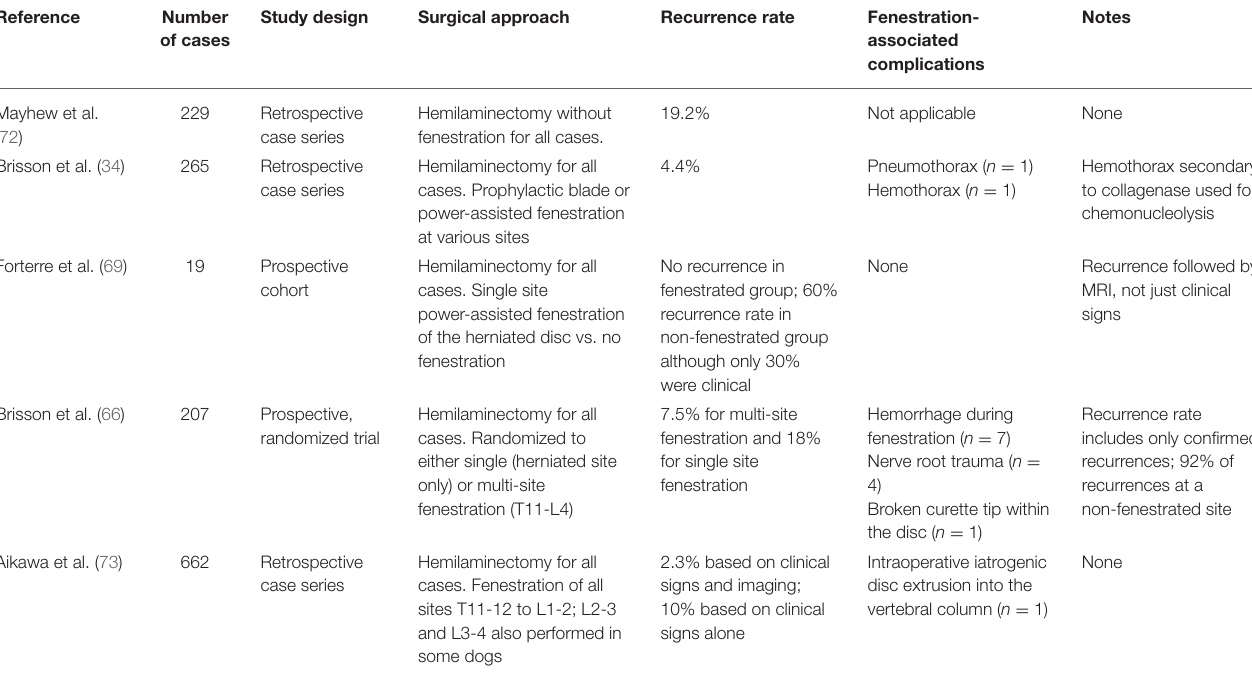
TABLE 5 | Results of recent large-scale contemporaneous studies evaluating outcome and recurrence after hemilaminectomy with